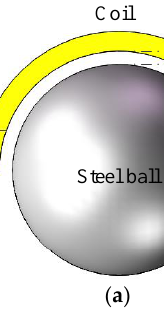
Figure 2. Model of steel ball surface detection based on SECS. ( a ) Distance between the coil and the steel ball; and ( b ) the structure of SECS coil.